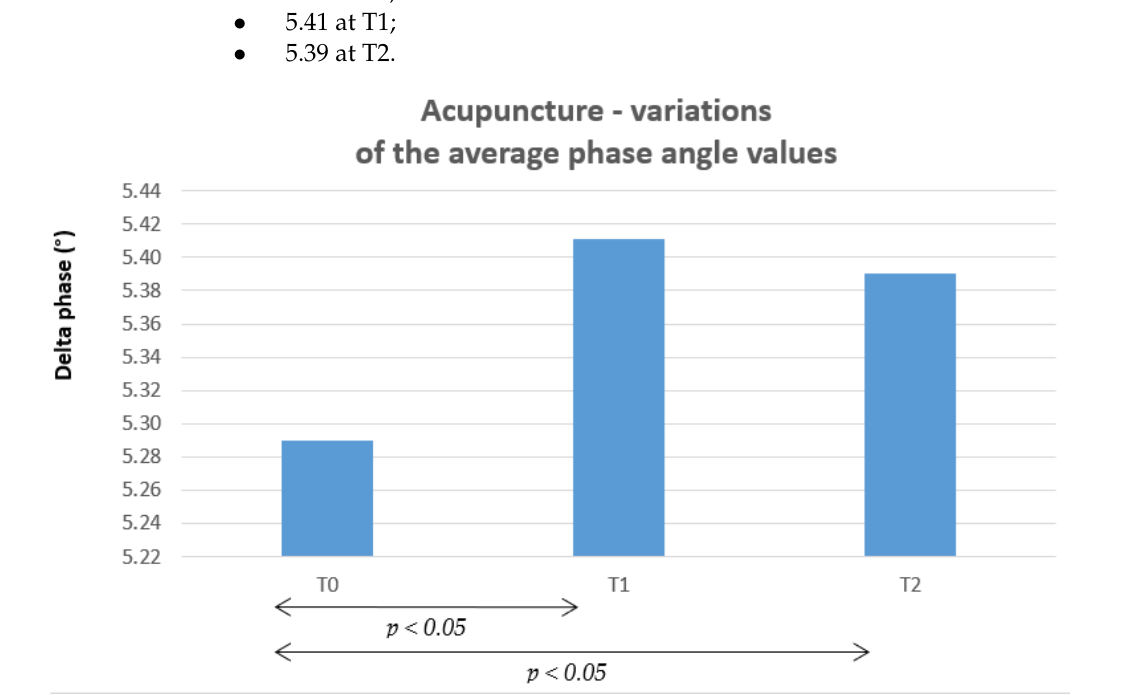
Figure 7. After acupuncture, average phase angle increases more at T1 and less at T2, in the same selected points (both variations are statistically significant). For the abdominal acupuncture group, the average phase angle is (Xc/Rz × 180/π).